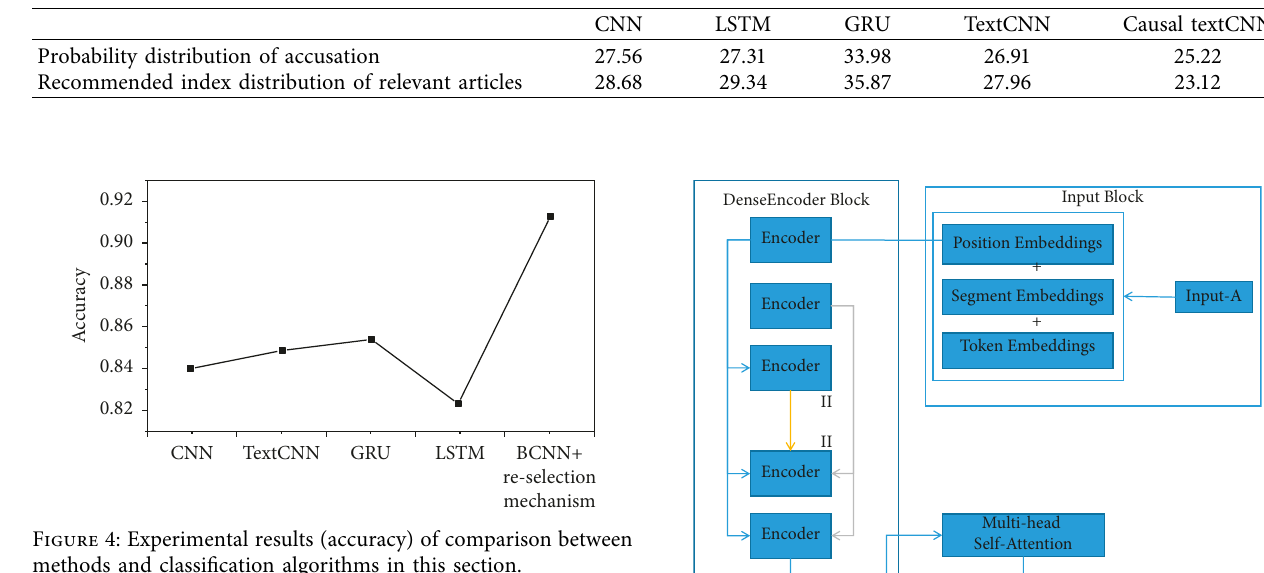
Table 6: RMSE scores of model before and after feature fusion.